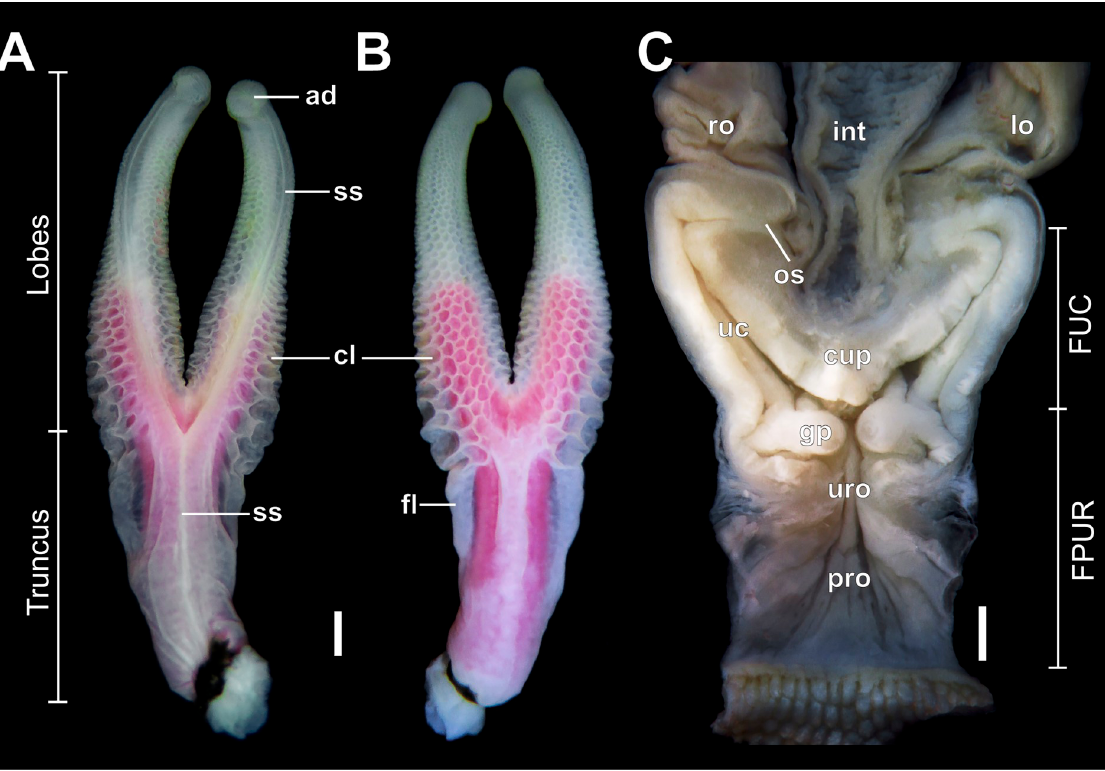
Fig 3. Male and female genital morphology of Tropidurus torquatus . Measurements are indicated for the hemipenial truncus, hemipenial lobes, female proctodeal-urodeal cloacal region (FPUR), and female urodeal corns (FUC). Right hemipenis in (A) ventral and (B) dorsal view, and female internal genitalia (C). Figure legends: ad, apical disc; gp, genital papilla; int, intestine; lo, left oviduct; os, oviduct sphincter; ro, right oviduct; uc, urodeal corn; uro, urodeal region; pro, proctodeal region; ss, spermatic sulcus. Scale bar: